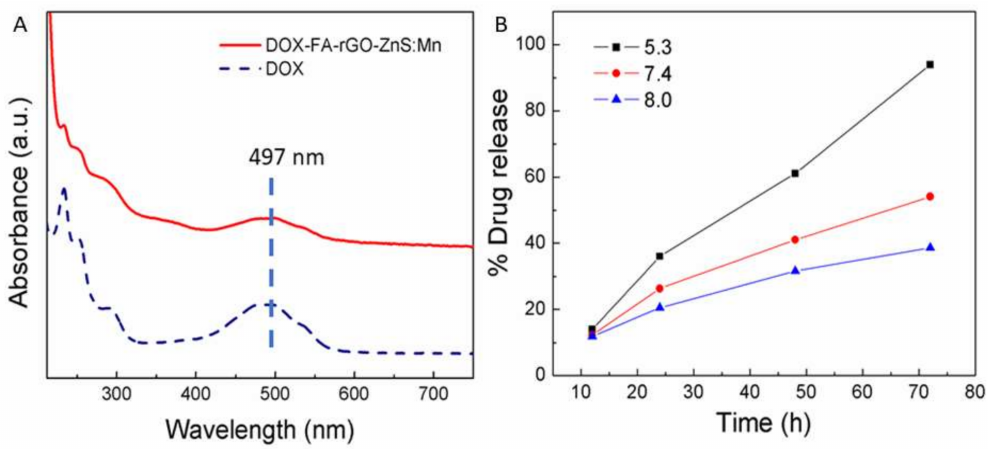
Figure 4. ( A ) UV-Vis absorbance spectra of free DOX and DOX-FA-rGO/ZnS:Mn nanocomposite; ( B ) Cumulative percent drug release over time at different pH